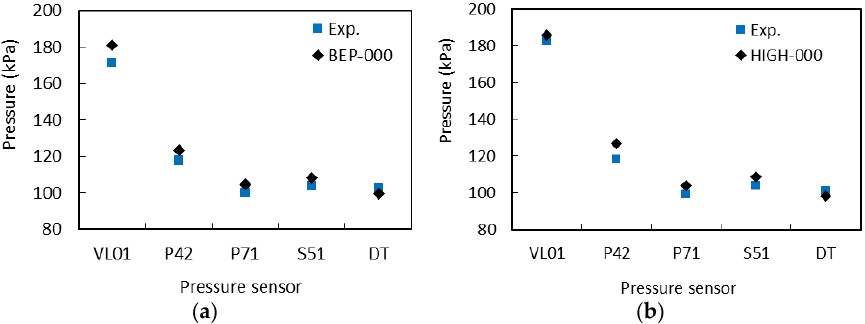
Figure 13. Average pressure loading in the model Francis turbine under BEP ( a ) and HL ( b ) operating conditions [16].